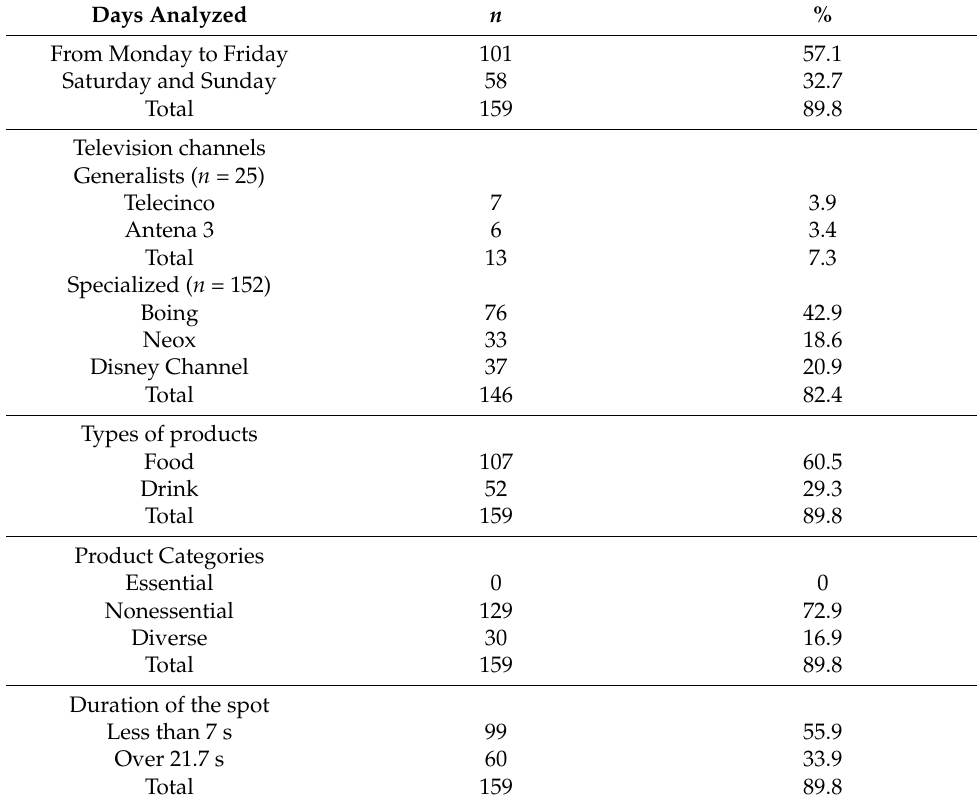
Table 4. Overall noncompliance with the drink and food PAOS Code advertising to the under 12s in our sample by days of the week and TV channels, type of products, product categories and duration of the